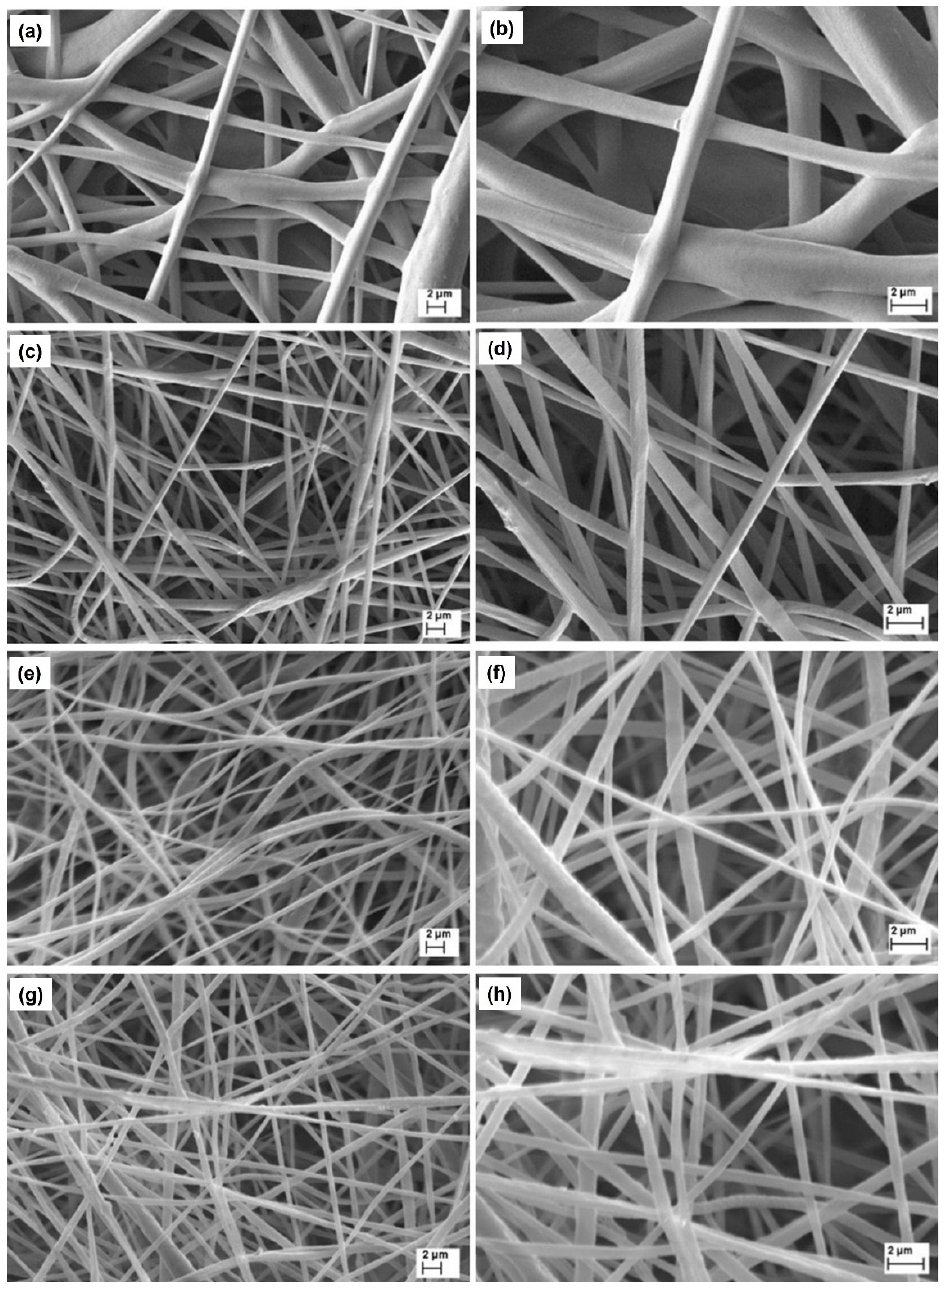
Figure 3. SEM images (5000× and 10,000× magnification) of PCL–fiber ( a , b ), MIM– β CP ( c , d ), functionalized MIM– β CP ( e , f ), and NIM ( g , h ).